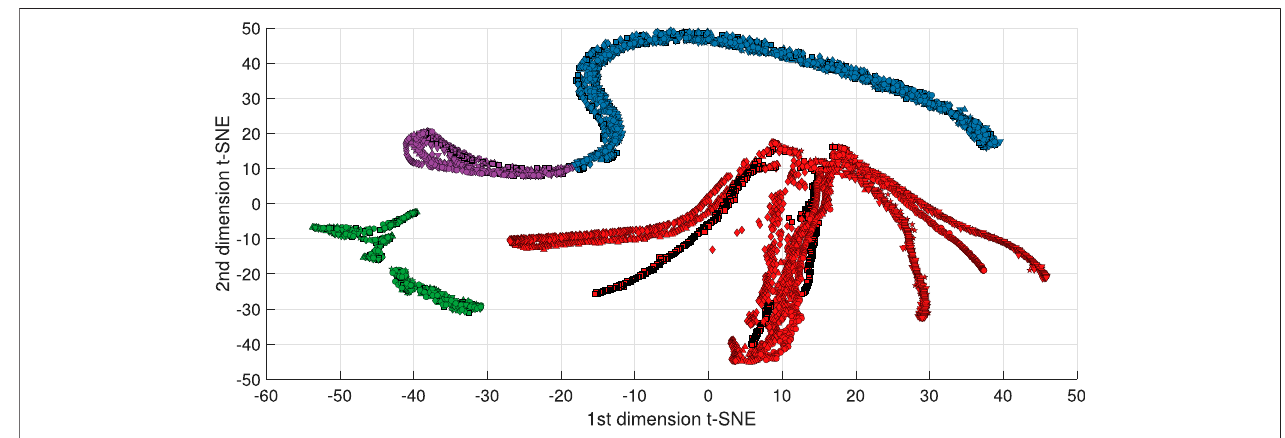
FIGURE 5 | t-SNE embedded space for Pensim